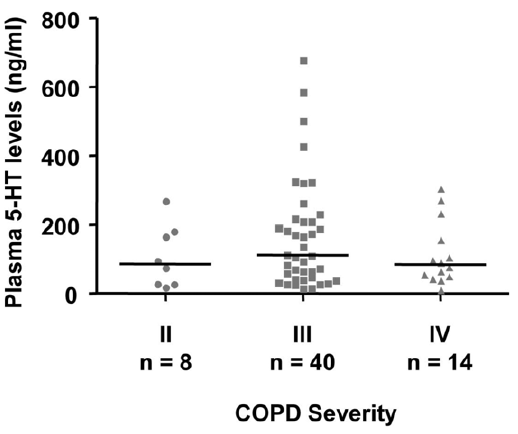
Figure 2. Plasma 5-HT levels of COPD patients with different stages. Solid horizontal line represents the median value. No significant difference was found across the groups.